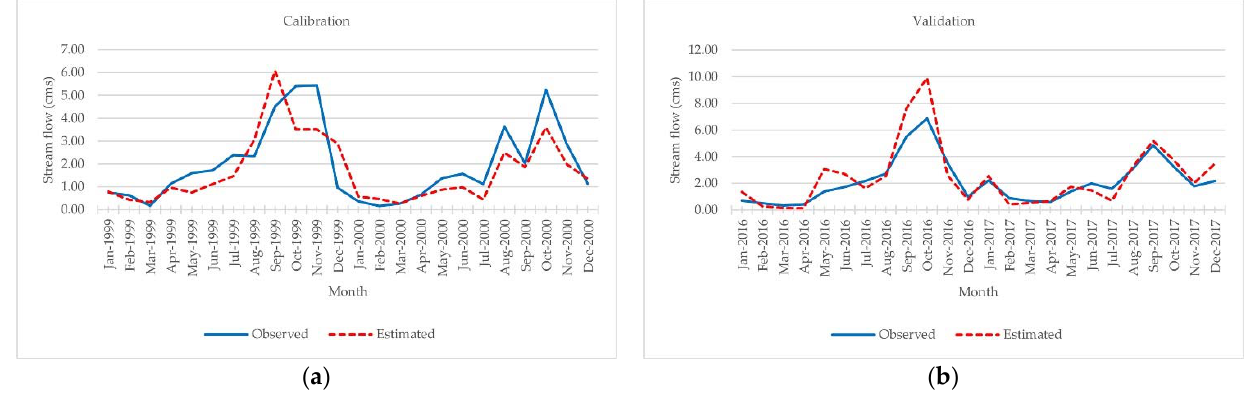
Figure 10. Monthly observed and estimated streamflow at Khlong Bang Yai watershed under the wet year condition: ( a ) calibration period; ( b ) validation period.